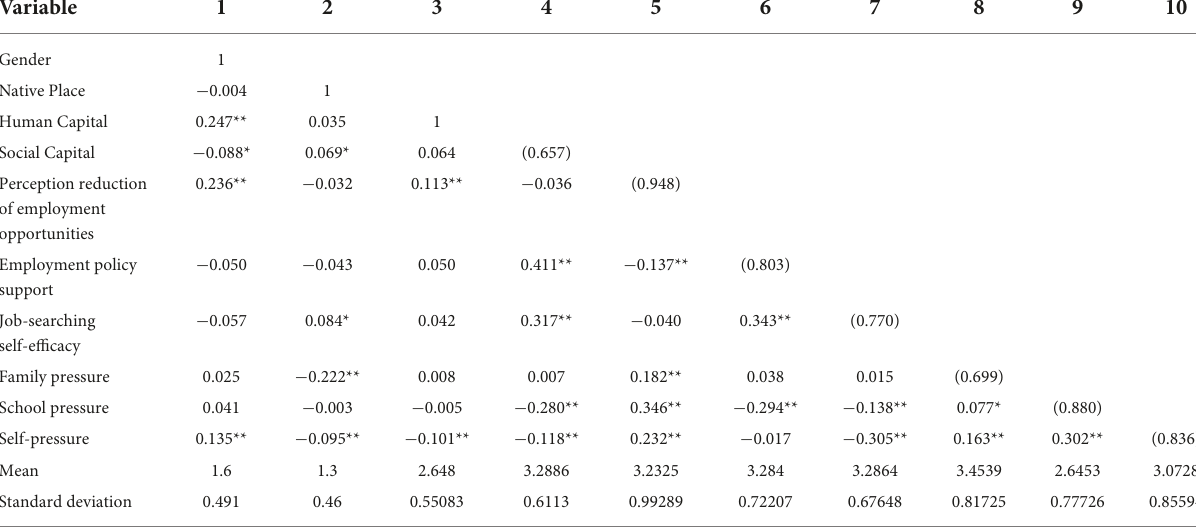
TABLE 3 Means, standard deviations, and correlation analysis results of various variables ( n = 810).